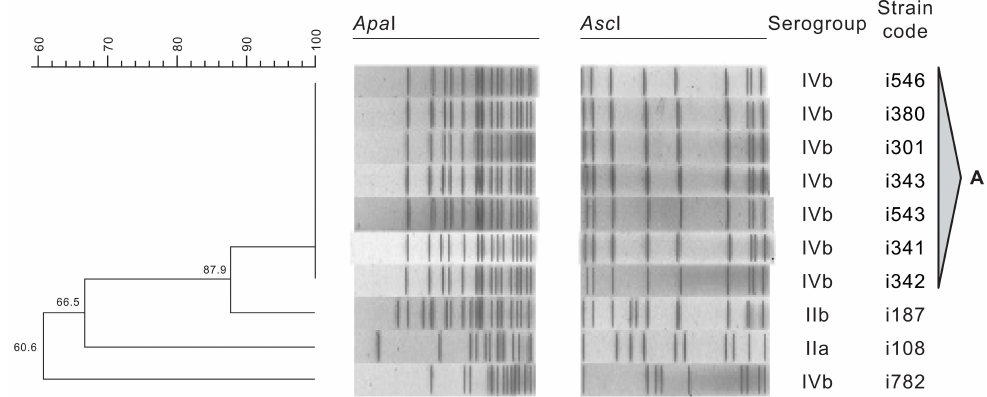
Figure 2. Dendrogram of L. monocytogenes PFGE profiles and